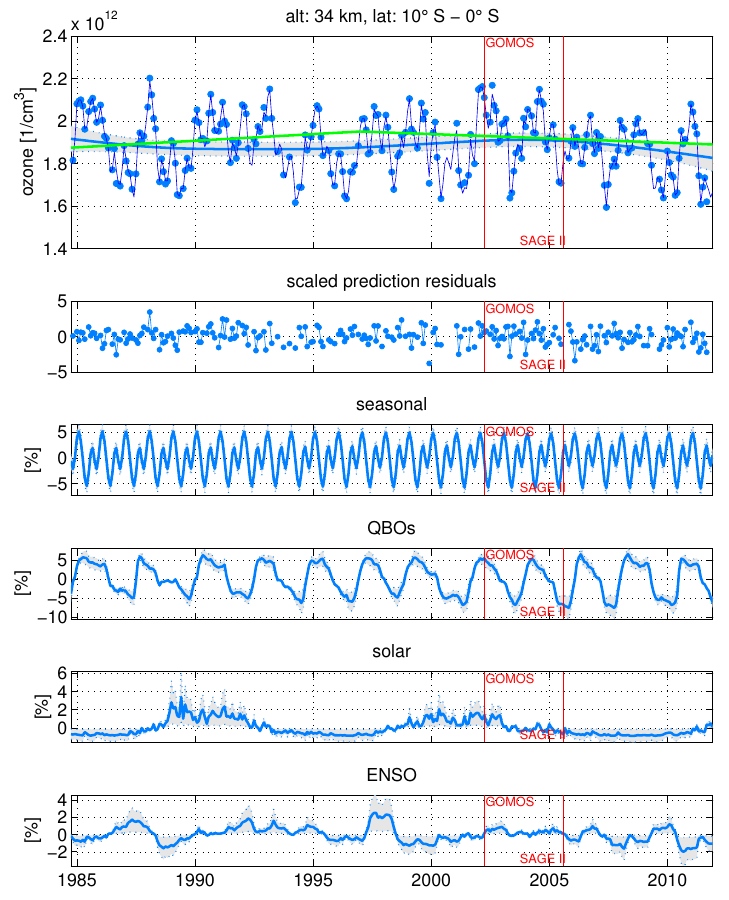
Figure 4. Some of the DLM model components for 10–0 ◦ S, 34km, see Fig. 3 for explanation. We see noticeable difference between DLM Fig. 4. Some of the DLM model components for 10 ◦ S–0 ◦ S, 34km, see Fig. 3 for explanation. We see and linear regression fits drawn with a solid green line on the top panel. noticeable difference between DLM and linear regression fits drawn with a solid green line on the top panel. Table 1. Specification of priors for auxiliary model parameters estimated by MCMC. The prior distributions for the model error standard deviation parameters were log-normal, log N( log (µ),σ 2 ) with values of µ and σ given in the table. For simplicity, the same relative priors are used in all the altitude–latitude regions. In Fig. 1 the prior distributions are plotted together with MCMC chain histograms that estimate the posterior distributions for one altitude-latitude